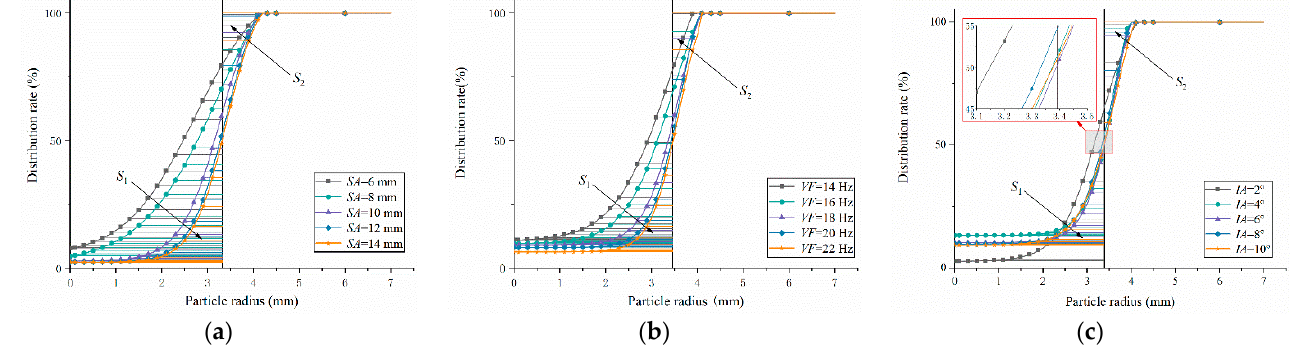
Figure 9. Curve of the distribution rate. ( a ) Curve of the distribution rate with amplitude; ( b ) Curve of the distribution rate with frequency; ( c ) Curve of the distribution rate with angle.